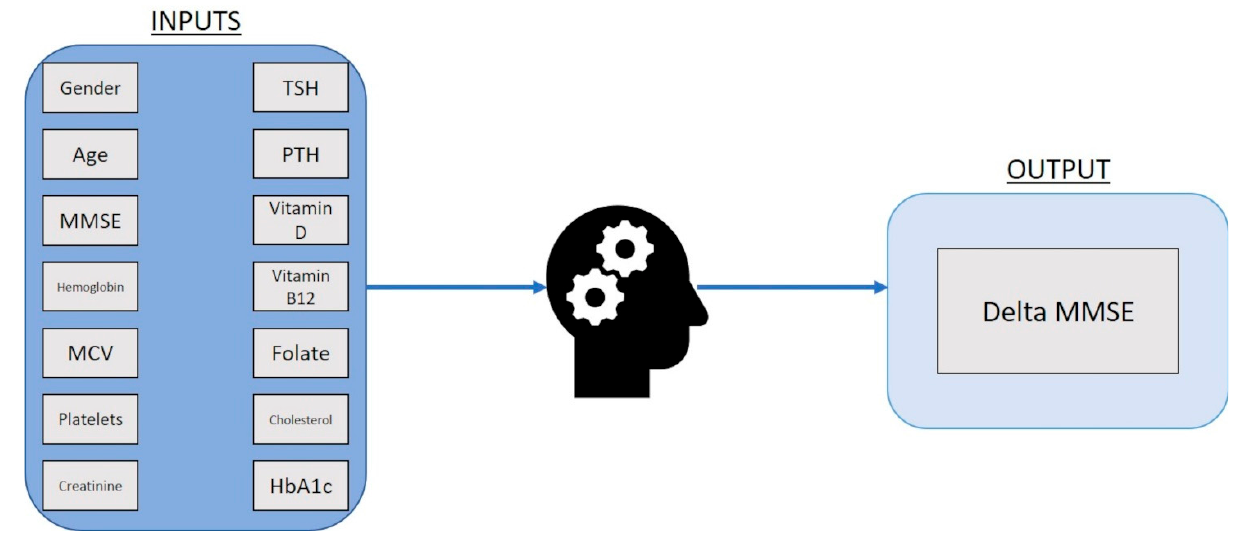
Figure 2. Inputs and output used for the ML models.